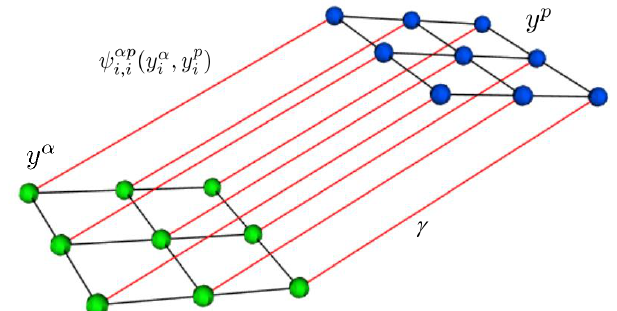
Figure 1. The graph representation of MRFL. Green nodes denote the random variables associated with y α , blue nodes denote the random variables associated with y p . Black lines denote the edges that model the spatial neighborhood dependencies. Red lines denote the cross links between y α and y p , ( y α ) . γ is the parameter that controls the influence of these encoding the potential interactions ψ α p , y p i i , i i interaction